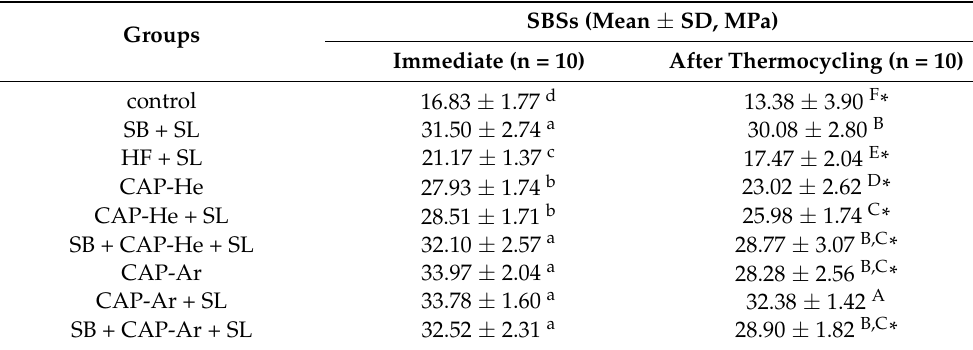
Table 5. Shear bond strength (SBS) of RNC specimens in different groups. SBSs (Mean ± SD, MPa) Groups Immediate (n = 10) After Thermocycling (n =